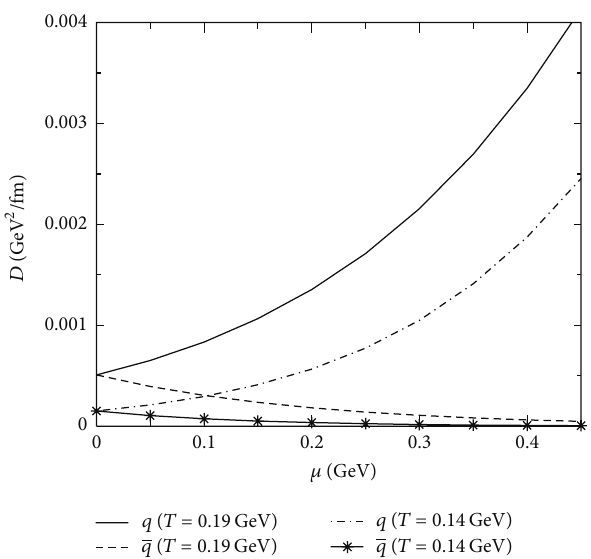
Figure 13: Variation of the diffusion coefficient of charm quark due to its interactions with light quarks and anti-quarks as a function of 𝜇 for different temperatures. ( 4.31 × 10 −3 GeV 2 /fm) for 𝑇 = 140 MeV (190 MeV). The drag and diffusion coefficients for bottom quarks are displayed in Figures 14 and 15, respectively, showing qualitatively similar behaviour as charm quarks. The drag coefficients for bottom quarks due to the process 𝑄 g → 𝑄 g are given by ∼3.15 × 10 −3 fm −1 and 6.93 × 10 −3 fm −1 at 𝑇 = 140 MeV and 190 MeV respectively. The corresponding diffusion coefficients are ∼ 1.79×10 −3 GeV 2 /fm and 5.38×10 −3 GeV 2 /fm at 𝑇 = 140 MeV and 190 MeV, respectively. The 𝜇 dependent drag and diffu- sion coefficients will be used later to evaluate the nuclear